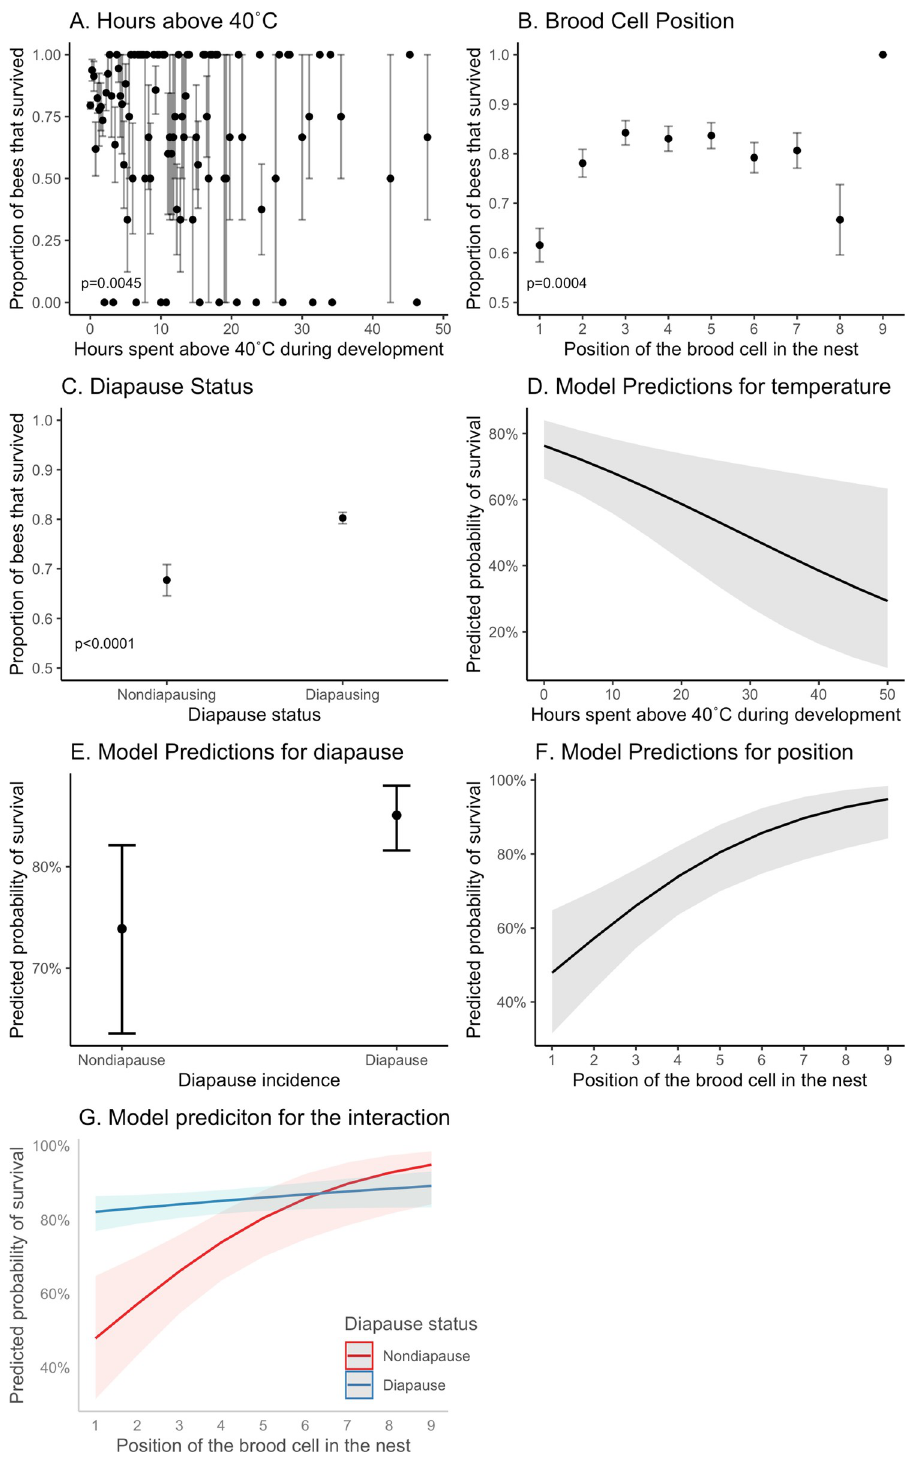
Fig 5. Survival to adulthood. (A) The number of hours spent above 40˚C significantly influenced survival. (B) The position of the brood cell in the nest, with 1 being the first brood cell built, significantly influenced survival. (C) Whether an individual chose to diapause or not diapause was significant. The predicted probabilities from the general linear mixed model for diapause incidence (D) and brood cell position (E) reinforce these patterns and show a significant interaction between the variables (F). Whiskers on A-C denote the standard error of the mean. Grey region in D-F denotes the 95% confidence interval around the model estimates. https://doi.org/10.1371/journal.pone.0254651.g005 PLOS ONE | https://doi.org/10.1371/journal.pone.0254651 August 3,